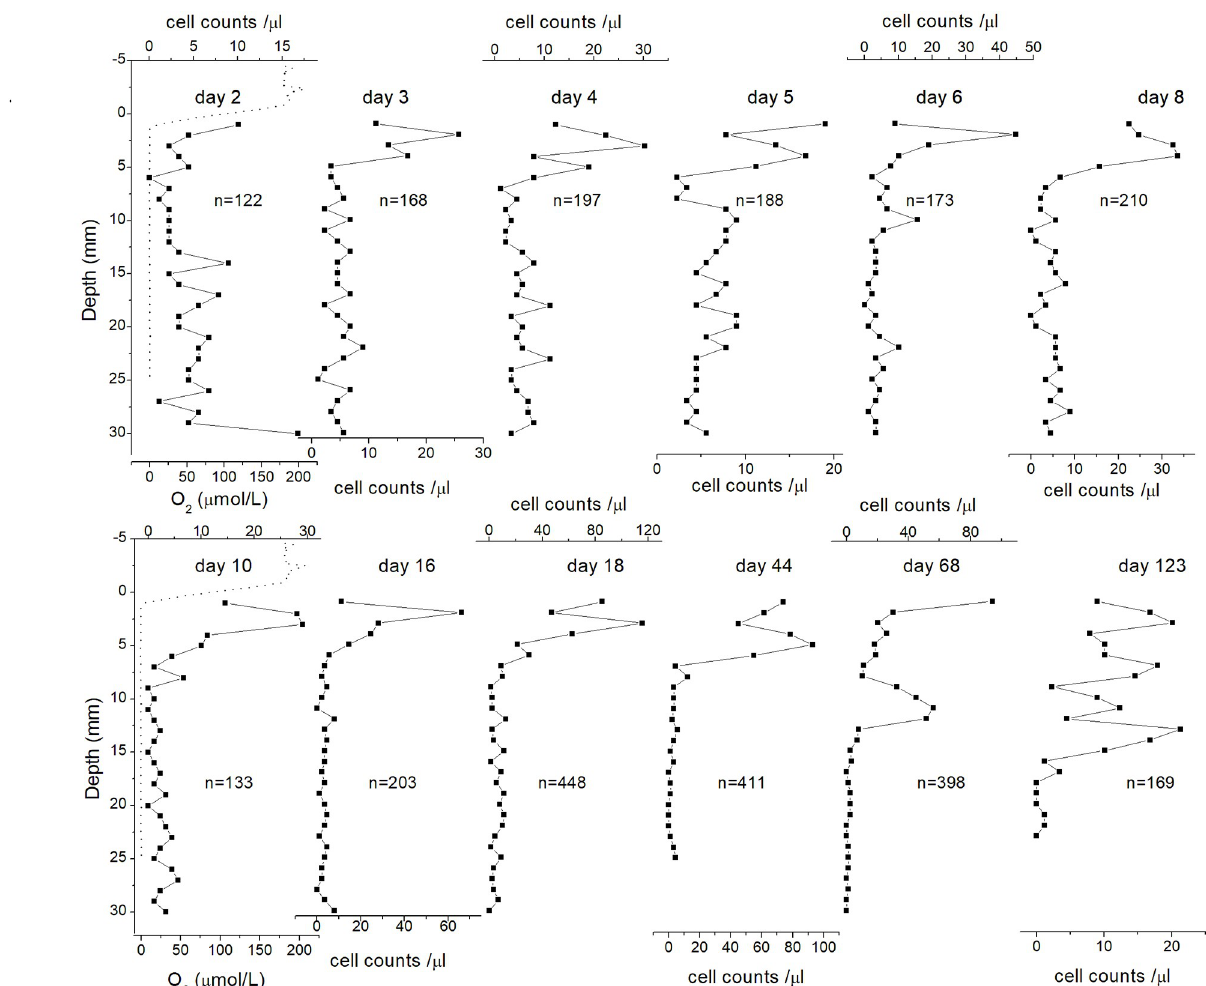
Fig 4. Vertical distribution changes with time. Development of M . bavaricum vertical distribution (square) and oxygen gradient (dotted line).